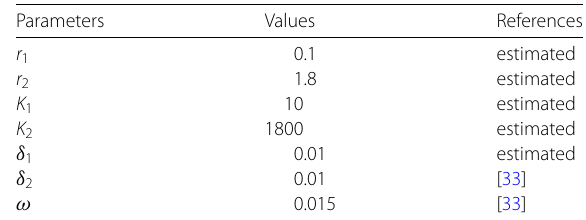
Table 1 Parameter values used for the numerical simulation